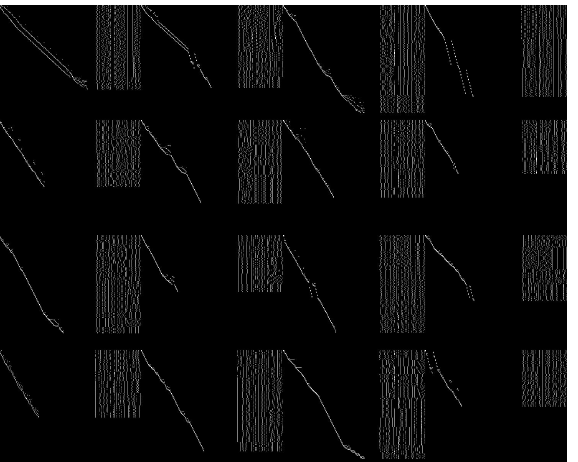
Figure 8. Input data of vertex-face adjacency ( A VF ) and vertex feature ( F V ) (4 × 4).